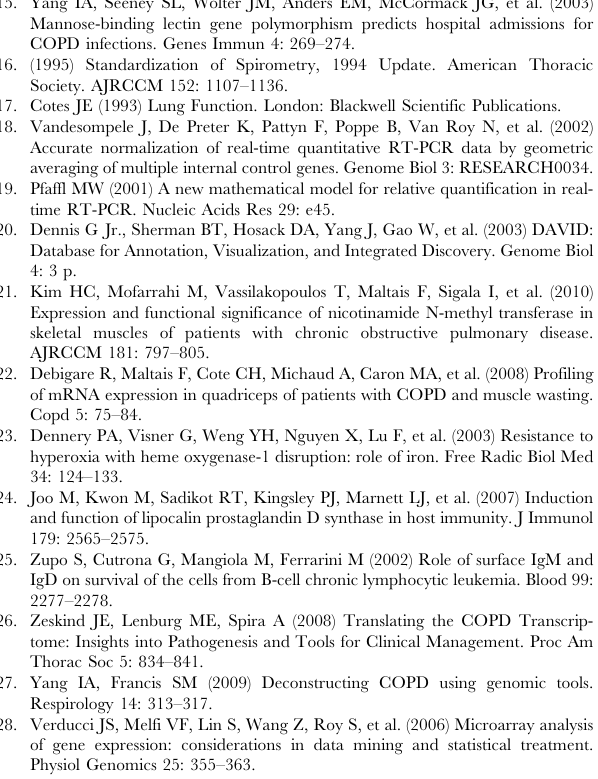
Figure S1 Histogram comparison of mRNA gene expression for the eight candidate genes in TPCH and public datasets. Figure S2 Gene ontologies enriched in TPCH and public datasets. Table S1 List of 46 genes associated with COPD severity identified by class comparison analysis. Table S2 Gene ontologies common to this study and previously published studies obtained using GOEAST analysis on the relevant datasets downloaded from GEO. Table S3 Gene ontologies enriched in TPCH-FEV 1 dataset. Table S4 Gene ontologies enriched in Ning et al FEV 1 dataset. Table S5 Gene ontologies enriched in Wang et al FEF 25–75% dataset.